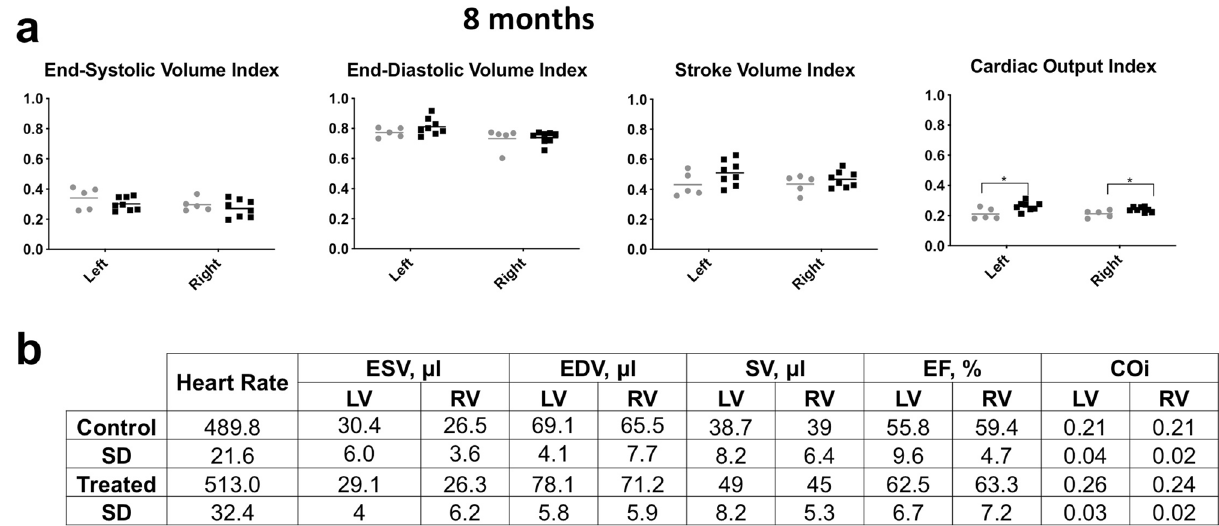
Figure 3. Heart function is similar in control and 2-DG treated mice. (a) Heart capacity was measured by MRI. Right and left ventricle End-Systolic and End-Diastolic Volume index, Stroke Volume index and Cardiac Output index, adjusted for body surface area (BSA = 20 × body weight (g) ^ 0.42). There was no significant difference in the Ejection Fraction (EF) (amount, or percentage, of blood that is ejected from the ventricles with each contraction (EF = (SV/EDV) × 100)), or the volume remaining after contraction (End-Systolic Volume (ESV) or systole). There was a small increase in the cardiac output index in the 2DG treated animals ( n = 8) versus controls ( n = 6) which was significant, p = 0.03 for the right ventricle and p = 0.02 for the left. ( b) Selected parameters measured to assess cardiac function. Heart rate (beats per minute), End-Systolic volume (ESV), End- Diastolic volume (EDV): volume of blood in a ventricle at the end of diastole, just before systole starts, Stroke volume (SV): volume of blood pumped from the left ventricle per beat (SV = EDV-ESV), Ejection Fraction (EF) (amount, or percentage, of blood that is ejected from the ventricles with each contraction (EF = (SV/ EDV) × 100)), and Cardiac Output index (COi). The last was derived from Cardiac Output (CO): amount of blood pumped by the heart per minute (CO = (Heart rate x SV)/1000) and the Cardiac Index (CI), which relates the cardiac output (CO) from left ventricle in one minute to body surface area (CI = (CO/BSA) × 10,000)). There were no significant differences in the EF, ESV, CO or